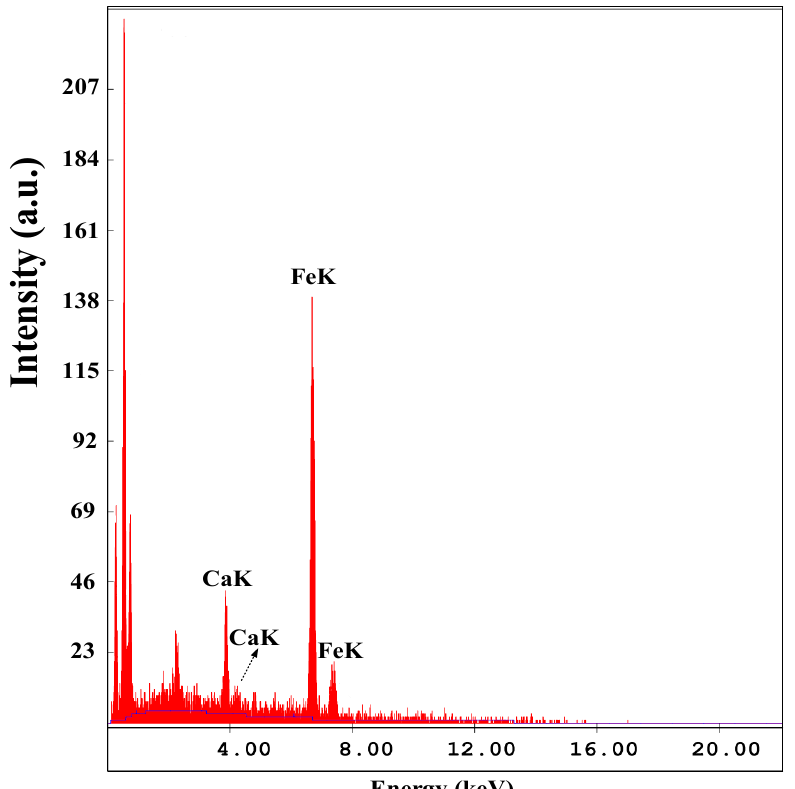
Figure 2. The Energy-Dispersive Spectroscopy (EDS) spectrum of the catalyst.